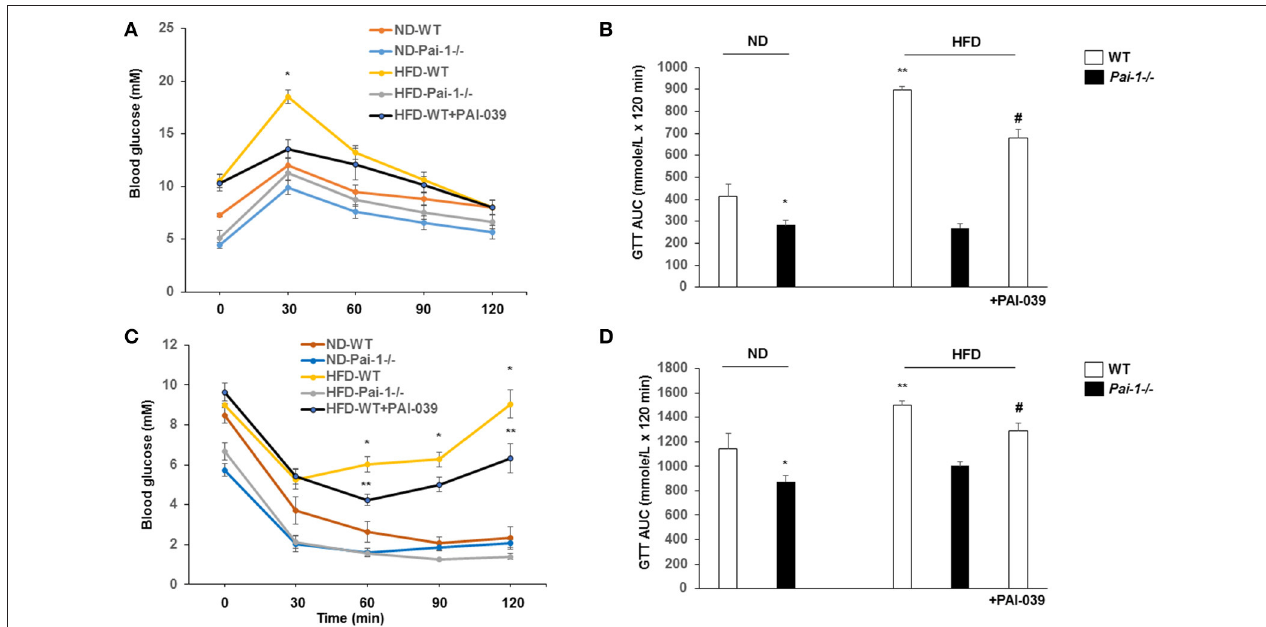
FIGURE 2 | Genetic deletion and pharmacological inhibition of PAI-1 improves glucose tolerance and insulin sensitivity. (A,B) Glucose tolerance tests (GTT) and AUC in each group. N = 6 per group. * P < 0.05 vs. ND-WT; ** P < 0.05 vs. ND-WT; # P < 0.05 vs. HFD-WT vehicle. HFD was associated with elevated fasting glucose levels and impaired glucose tolerance. PA1-1 depletion or inhibition (C,D) Insulin tolerance tests (ITT) and AUC in each group. N = 6 per group. * P < 0.05 vs. ND-WT; ** P < 0.05 vs. ND-WT; # P < 0.05 vs.